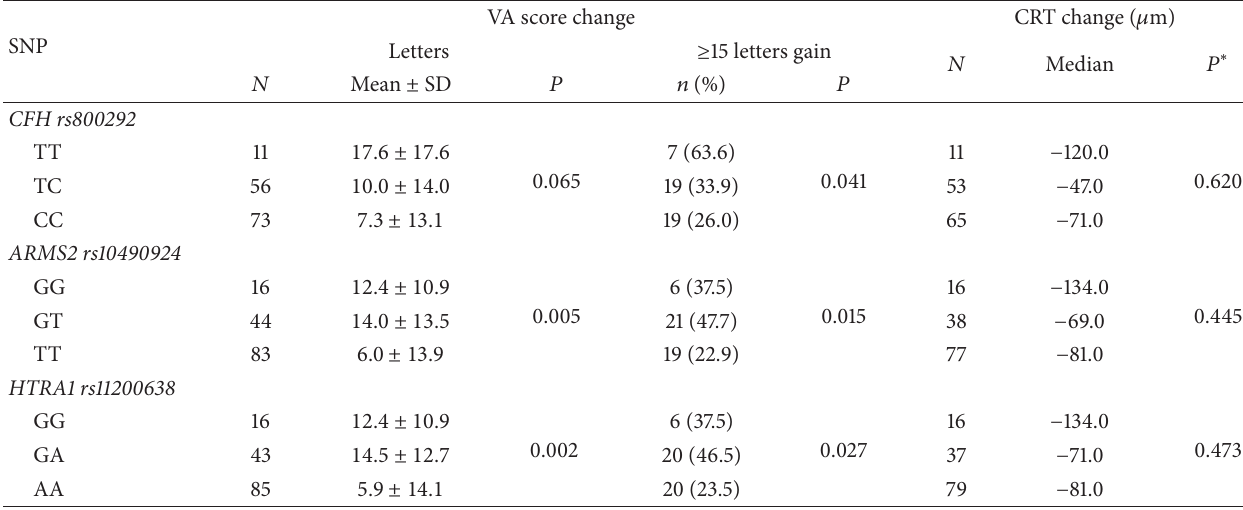
Table 3: Association between single-nucleotide polymorphisms and changes in visual acuity score and central retinal thickness. SNP